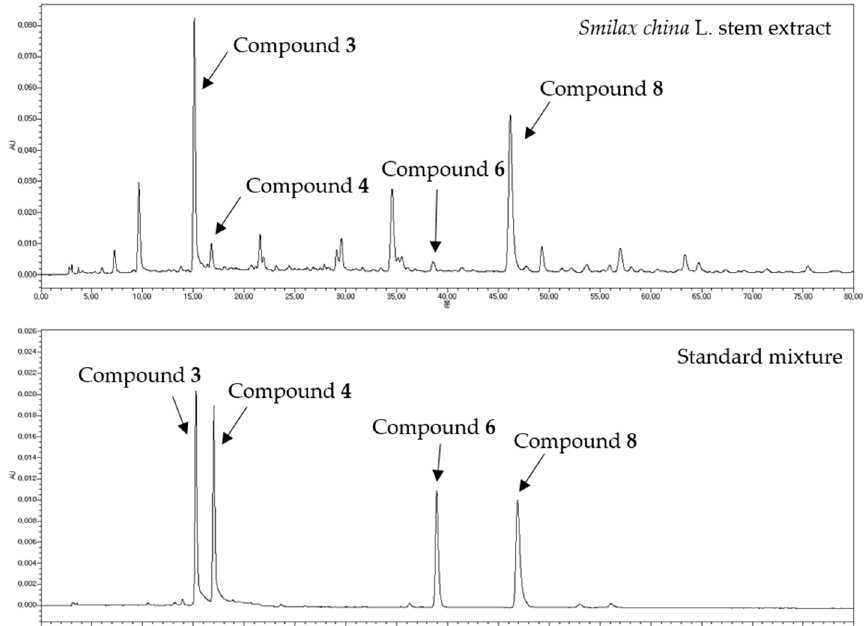
Figure 2. HPLC chromatograms of SCS 70% MeOH extract and four standard mixtures. Compound 3 : 3- O -chlorogenic acid (2.2.1.5.: 15.479); Compound 4 : 4- O -chlorogenic acid (Rt: 17.416); Compound 6 :